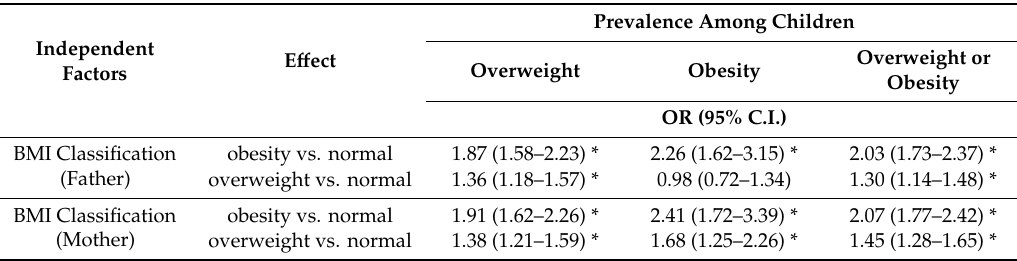
Table 8. Assessment of the odds ratio of the incidence of body mass disorders in children relative to mother and father’s BMI classification based on three two-factor logistic regression models (separately determined for incidence of overweight, obesity and overweight or